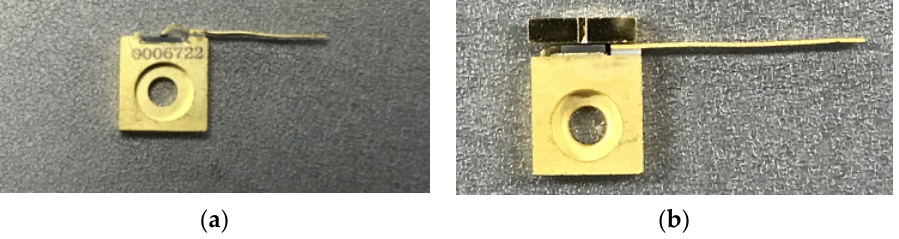
Figure 8. C-type and DC-type package structure physical diagrams. ( a ) C-type package structure physical diagram and ( b ) DC-type package structure physical diagram.